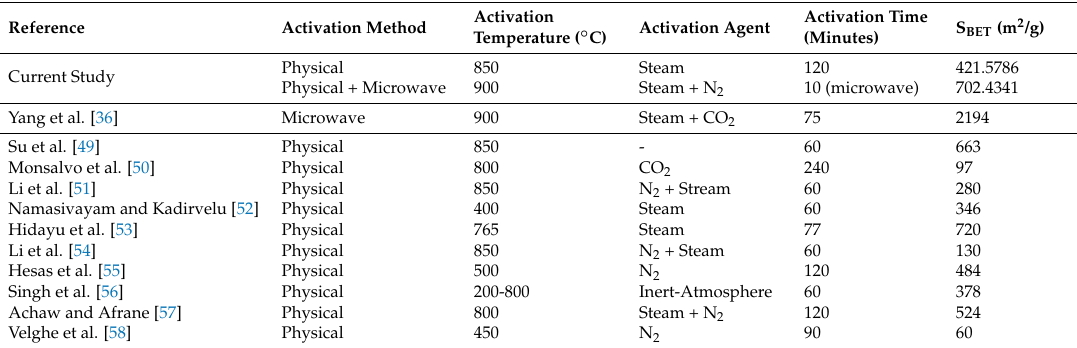
Table 4. Comparison of coconut shell sorbent specific surface area of the current study and literature data at optimum